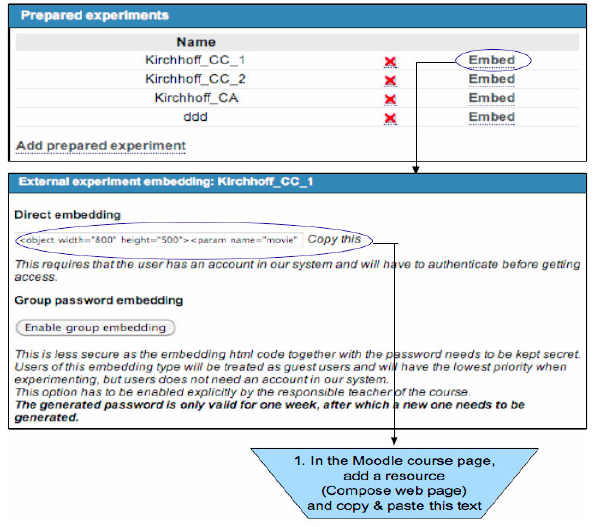
Figure 3. Embedding a direct link in Moodle, to a remote experiment in VISIR